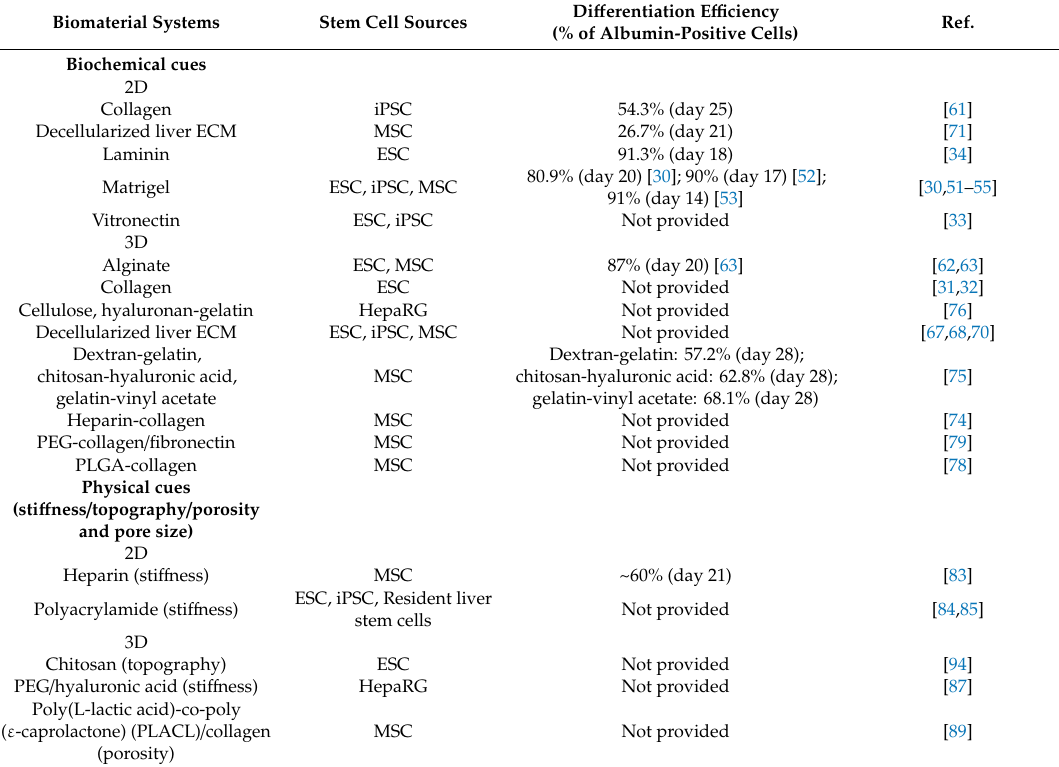
Table 1. Summary of 2D and 3D biomaterial systems applied in hepatic di ff erentiation of stem cells. Biomaterial